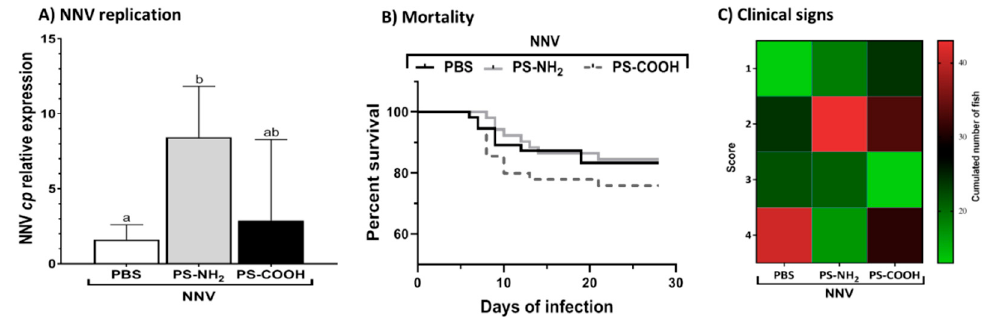
Figure 3. Exposure to functionalized NPs reduced the clinical signs under which fish died upon infection with nervous necrosis virus (NNV). European sea bass juveniles were intraperitoneally injected with phosphate buffer (PBS; Control) or with 1 μ g mL − 1 of 50 nm functionalized polystyrene NPs (PS-NH 2 and PS-COOH) and 96 h later were challenged with NNV by intramuscular injection. ( A ) NNV replication in the brain of NNV-infected specimens was determined by real-time PCR three days post-infection. Lowercase letters denote significant differences between groups according to ANOVA and Tukey’s post-hoc tests ( p < 0.05). ( B ) Kaplan–Meier survival curves showing the proportion of European sea bass survivors upon NNV challenge. ( C ) Heatmap presenting the cumulative number of fish showing disease signs based on their severity score: (1) changes in the colour of the skin, slower rhythm of swimming, and/or slower reaction to external stimuli such as feeding; (2) alterations in the swimming balance and/or erratic swimming spasms; (3) continuous erratic swimming; and (4) complete incapacity to maintain balance, swim, and/or move without external stimuli.